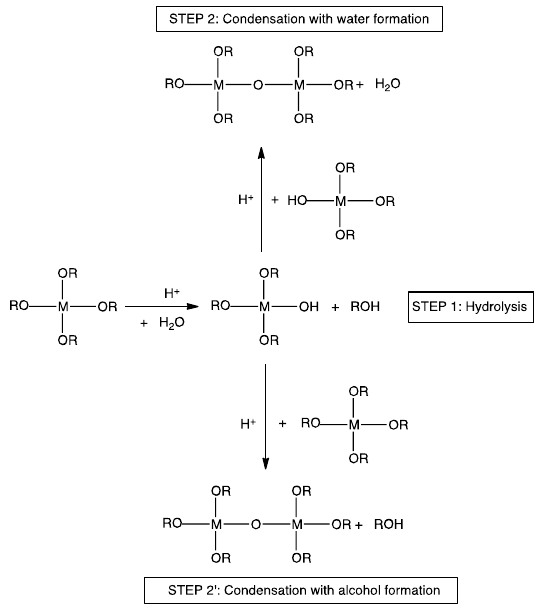
Figure 2. Schematic representation of sol-gel reactions taking place in acidic conditions (M = (semi)metal).